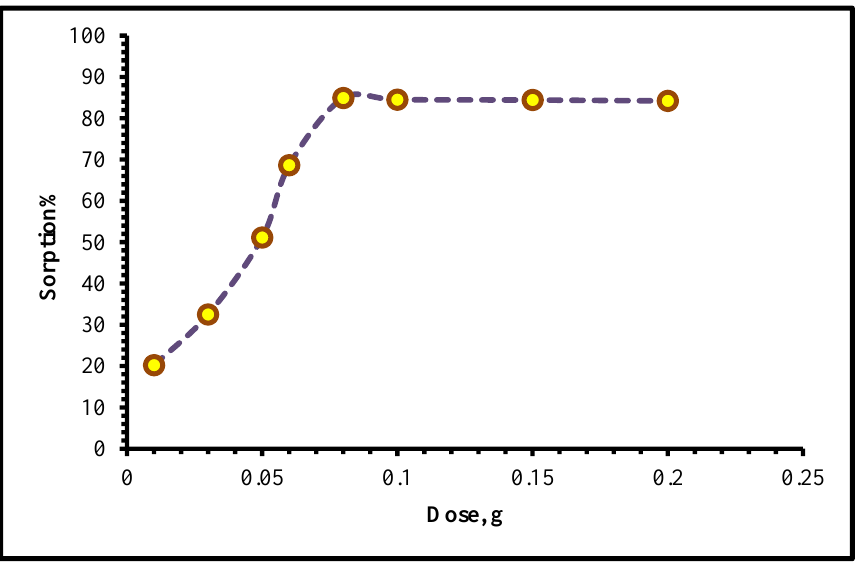
Figure 8. Effect of the HNAP/QA dose on the adsorption % of W(VI) (pH 4.5, W(VI) =250 mg L −1 , 20 mL solution, 30 min, room temperature).